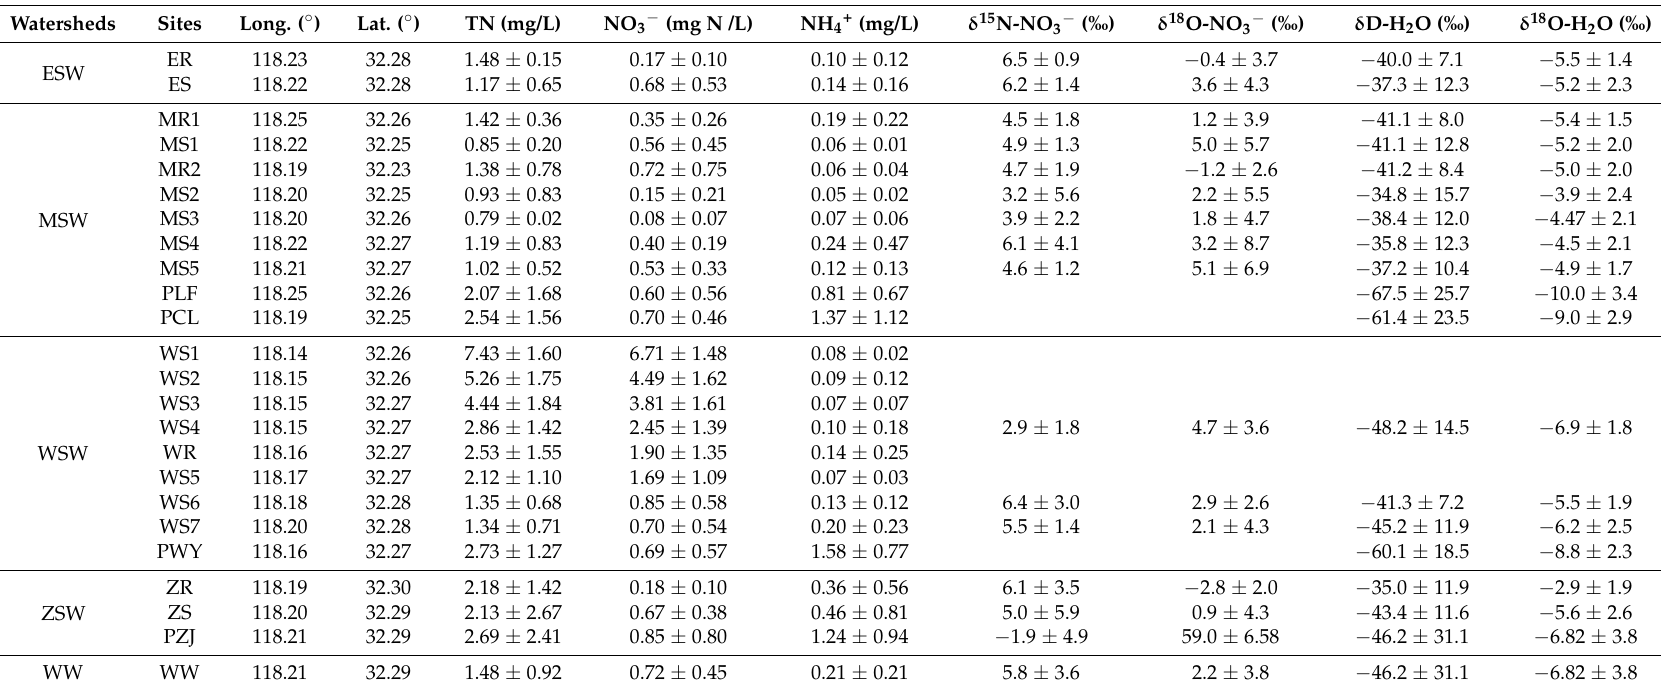
Table 3. Mean and standard deviation of nitrate concentration and isotopic